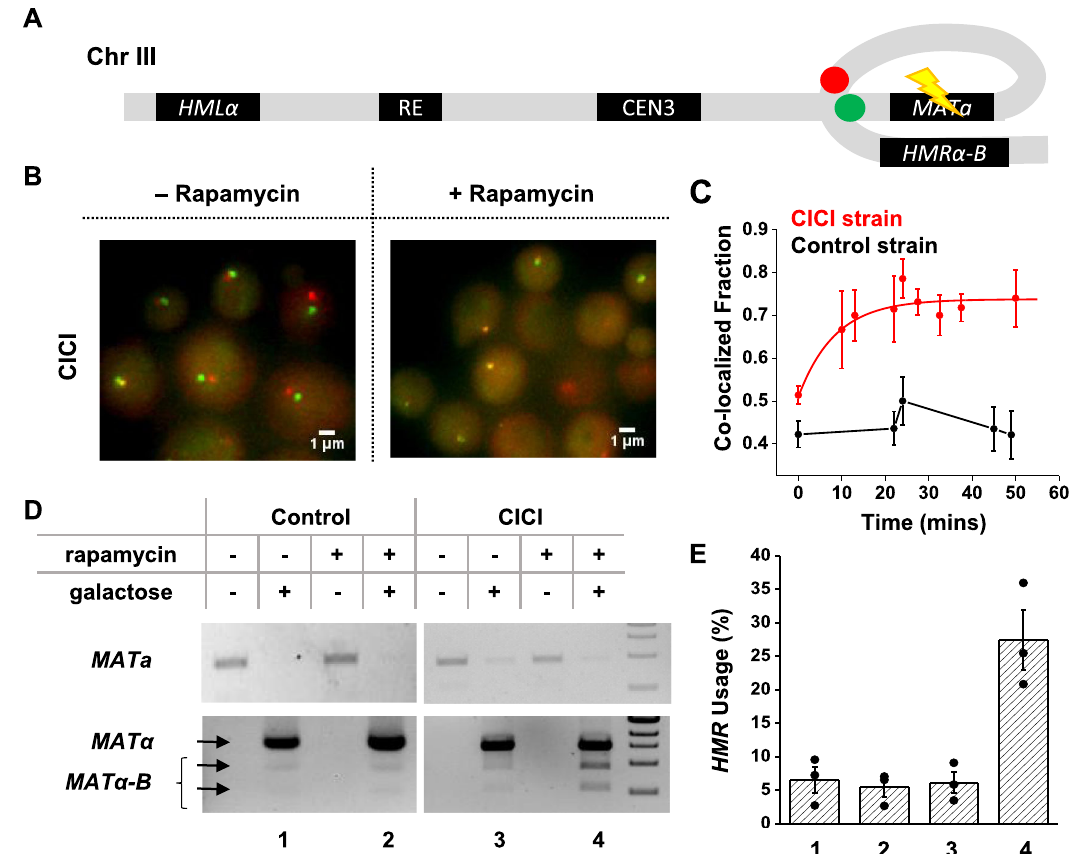
Fig. 5 CICI affects the donor preference in homology-directed DNA repair. A Engineered proximity between MATa and HMR α -B by CICI. Green and Red dots: LacO and TetO arrays; Flash symbol: HO digestion. B Visualization of the MATa and HMR α -B loci ± rapamycin. C Fraction of co-localization as a function of rapamycin incubation time in the CICI (red) or the control strain (black) used in the mating-type switching assay. The total numbers of data points were 226 for the CICI strain and 272 for the control. Error bars represent standard error in the fraction. D Quantitative analysis of HMR usage in yeast mating-type switching. Top gel: PCR of the MATa sequence, which decreases after the HO induction (representing the switching from a to α or α -B). Bottom gel: PCR of the MAT α sequence followed by BamHI digestion. Undigested (top arrow)/digested bands (bottom two arrows) represent the usage of HML ( α ) and HMR ( α -B). 1 kb DNA ladder is shown on the right. E The fraction of HMR usage for the four conditions in D , which was calculated as the sum intensity of the lower two bands divided by the sum intensity of all three bands. Data are presented as mean values ± SEM from three biological repeats. Source data for C – E are provided as a Source Data fi